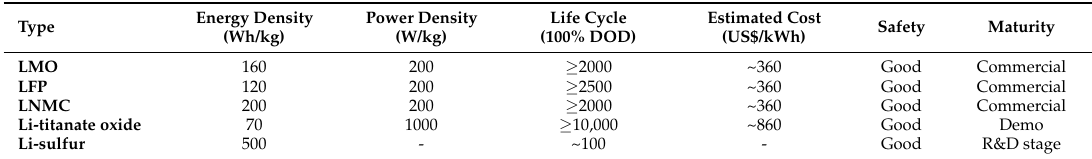
Table 2. Properties of the different types of Li-ion battery